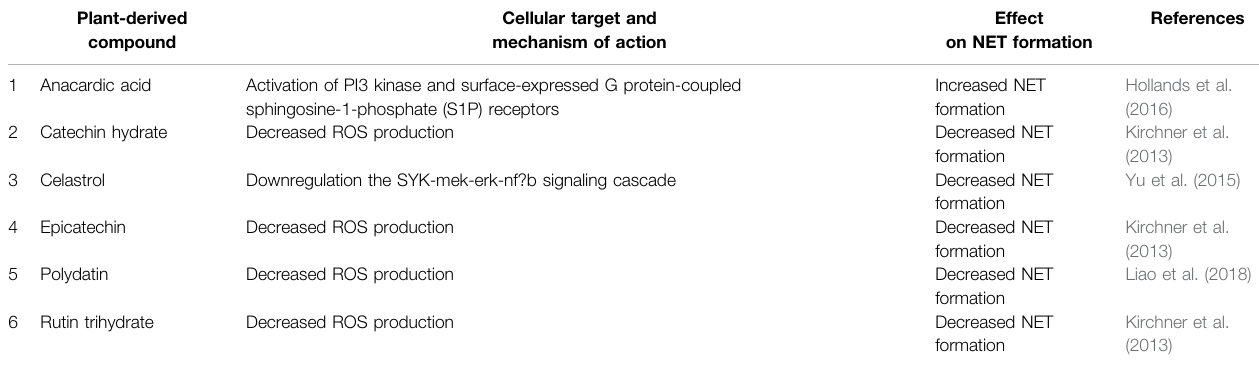
TABLE 8 | List of selected compounds isolated from plant material with documented impact on NET formation. Plant-derived